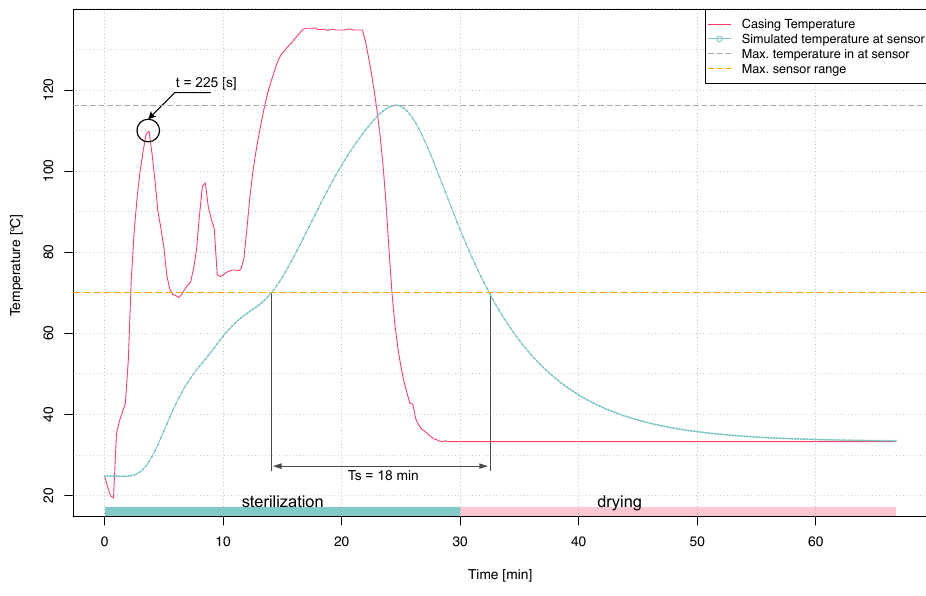
Figure 11. Simulated sterilization procedure and drying after sterilization. As shown, the maximum temperature reached by the thermistor is 116 °C. A shift of the peak in relation to temperature is also visible on the prototype’s surface. It is caused